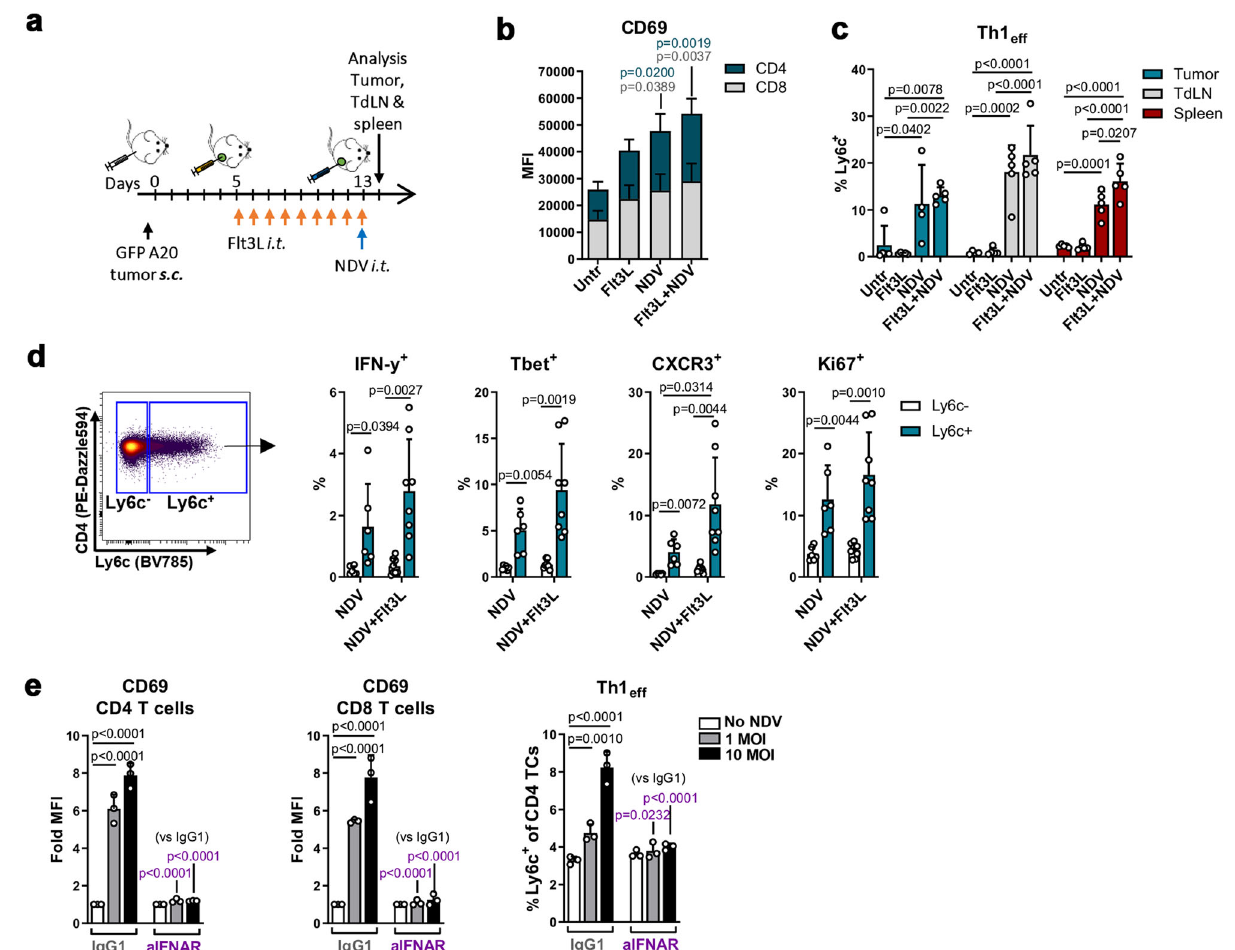
Fig. 5 | NDV therapy inducestype I IFN-dependent T cell activation. a GFP + A20 tumor-bearing mice were treated as indicated and tumor, TdLNs and spleens were harvested and analyzed by spectral fl ow cytometry ( b – d ). b Stacked bar graphs of activation marker expression on intratumoral CD8 + and CD4 + T cells. One-way ANOVAwith Tukey ’ s multiple comparisons test (vs untreated). c Percent Ly6c + Th1 effector cells (Th1 eff ) within CD4 + T cells. One-way ANOVA with Tukey ’ s multiple comparisons test; n =5 mice per group ( b , c ). d Tumors from NDV-alone or Flt3L